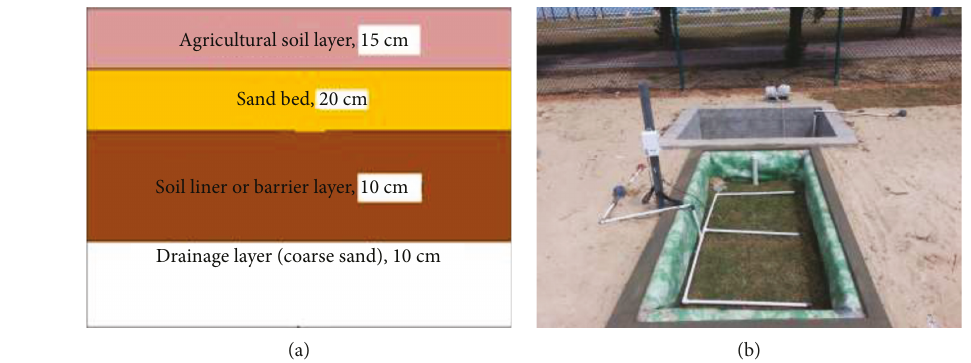
Figure 1: (a) Typical fi eld section pro fi le and (b) section view.